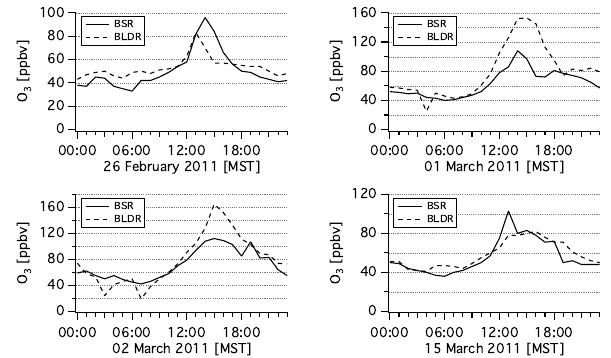
Figure 3. O 3 mixing ratios during four episodes at Boulder sites February to March